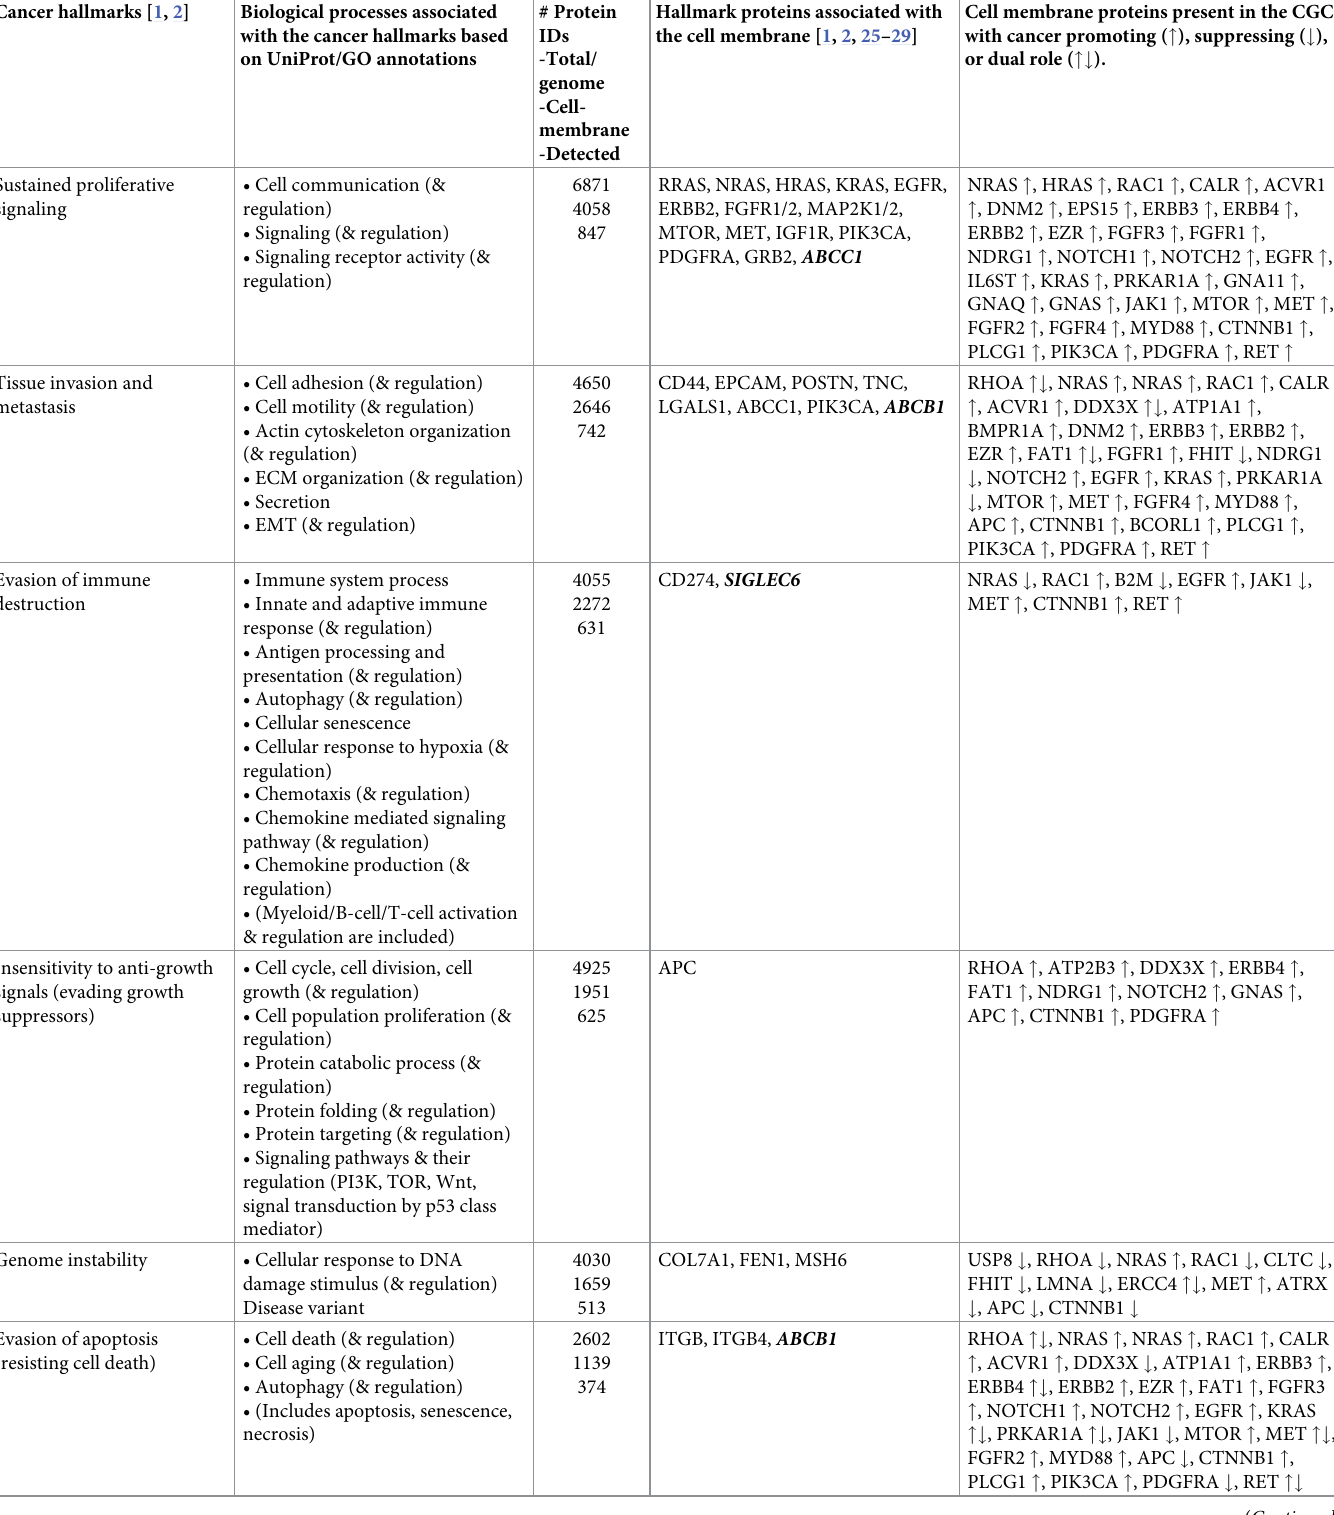
Table 1. Cancer hallmarks defined by GO biological processes and examples of cell-membrane proteins associated with the hallmarks. Cancer hallmarks [1, 2] Biological processes associated with the cancer hallmarks based on UniProt/GO annotations